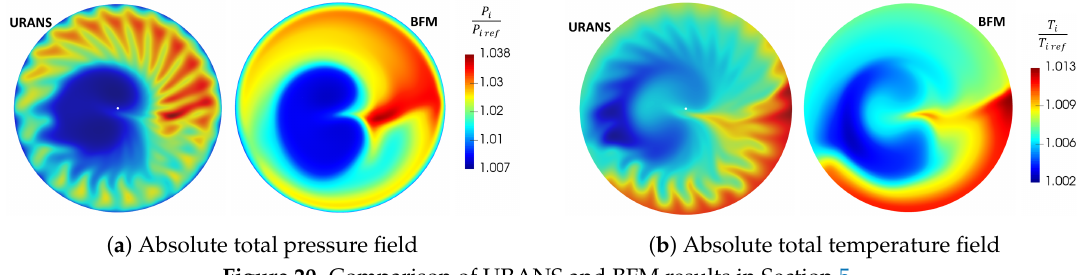
Figure 20. Comparison of URANS and BFM results in Section